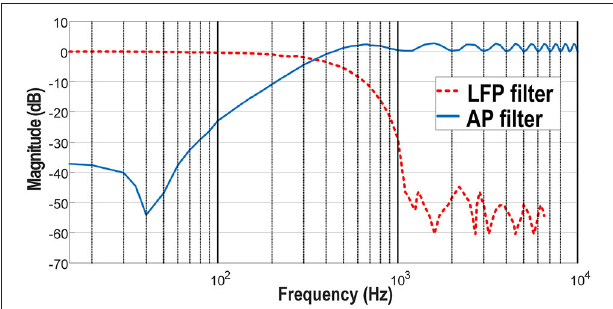
FIGURE 6 | Recordings of synthetic signals are presented. (A) Digitally filtered and decimated LFP signal. (B) Recorded, digitally filtered, detected, and compressed APs. The magnification shows the uncompressed AP signal (black) superimposed with the decompressed detected APs (red). (C) Recorded original raw signal. (D) EMG recorded in parallel with the neural